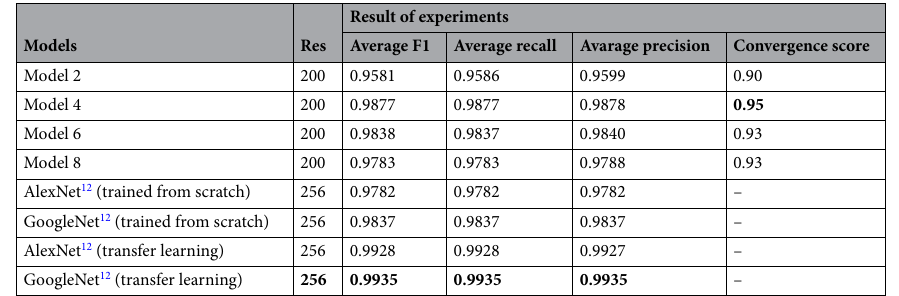
Table 3. The results of the plant village experiment. Significant values are in bold.